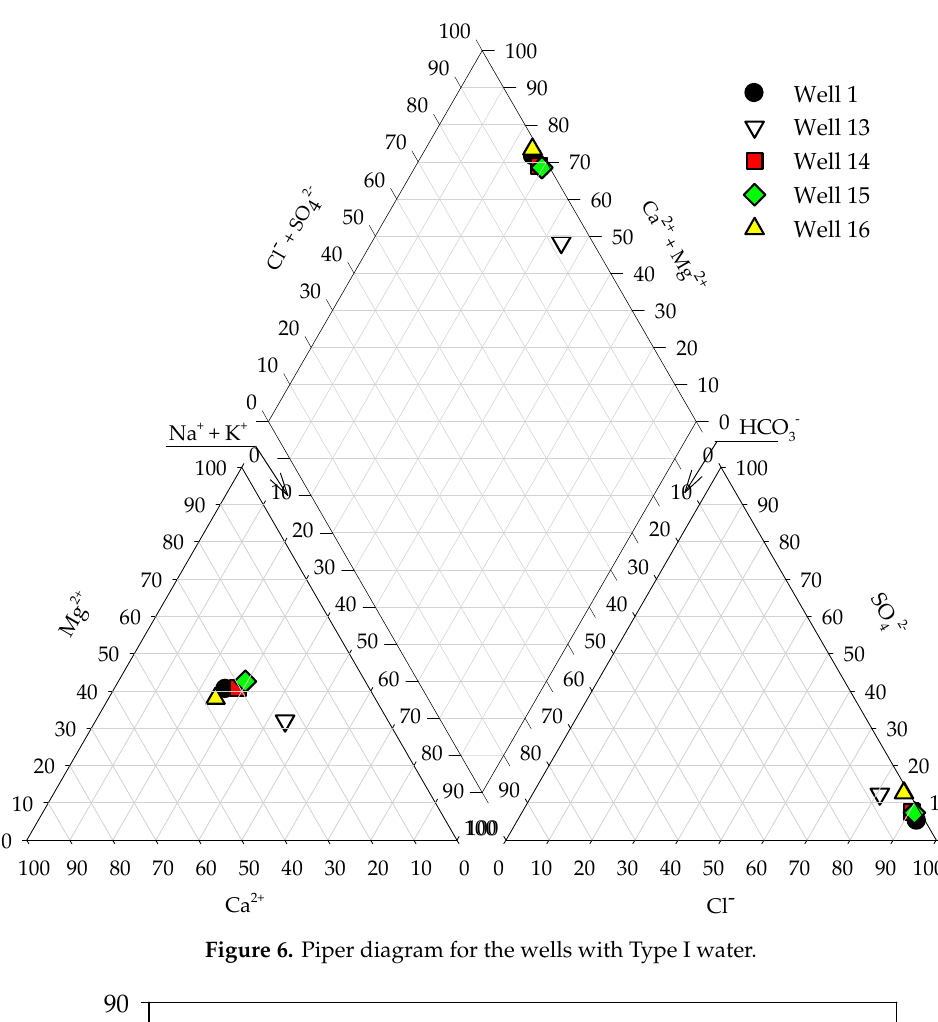
Figure 6. Piper diagram for the wells with Type I water.